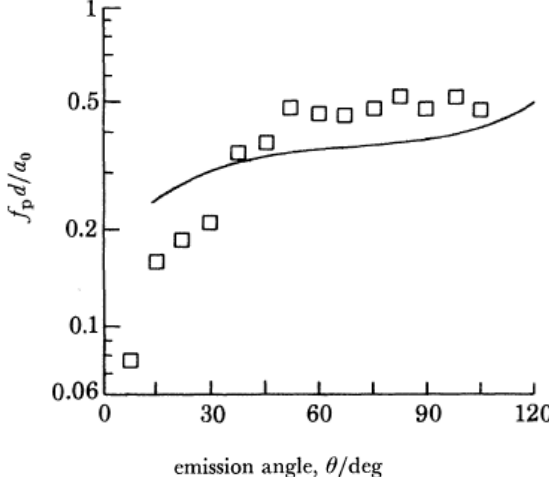
Figure 9. Peak of the jet noise predicted by Mankbadi and Liu [40] vs. the experimental data of Lush [41].